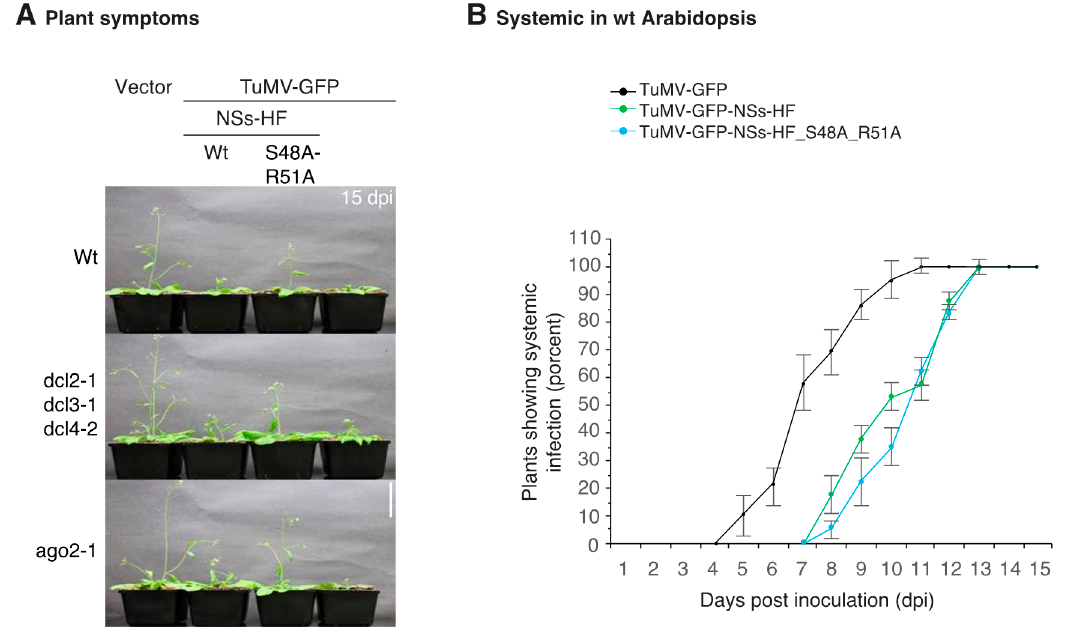
Figure 6. Systemic movement and symptoms in A. thaliana (Arabidopsis) plants. Wt, dcl2-1 dcl3-1 dcl4-2 triple mutants or ago2-1 single mutant plants were inoculated by Agroinfiltration with empty vector, TuMV-GFP expressing active or suppressor-deficient NSs-HF, or with TuMV-GFP. ( A ) Representative symptoms in Arabidopsis plants at 15 dpi. Scale bar: 6 cm. ( B ) Proportion (%) of plants showing systemic infection of inflorescence. Points represent average (±standard error) of three repetitions, each consisting of 18 plants per treatment.